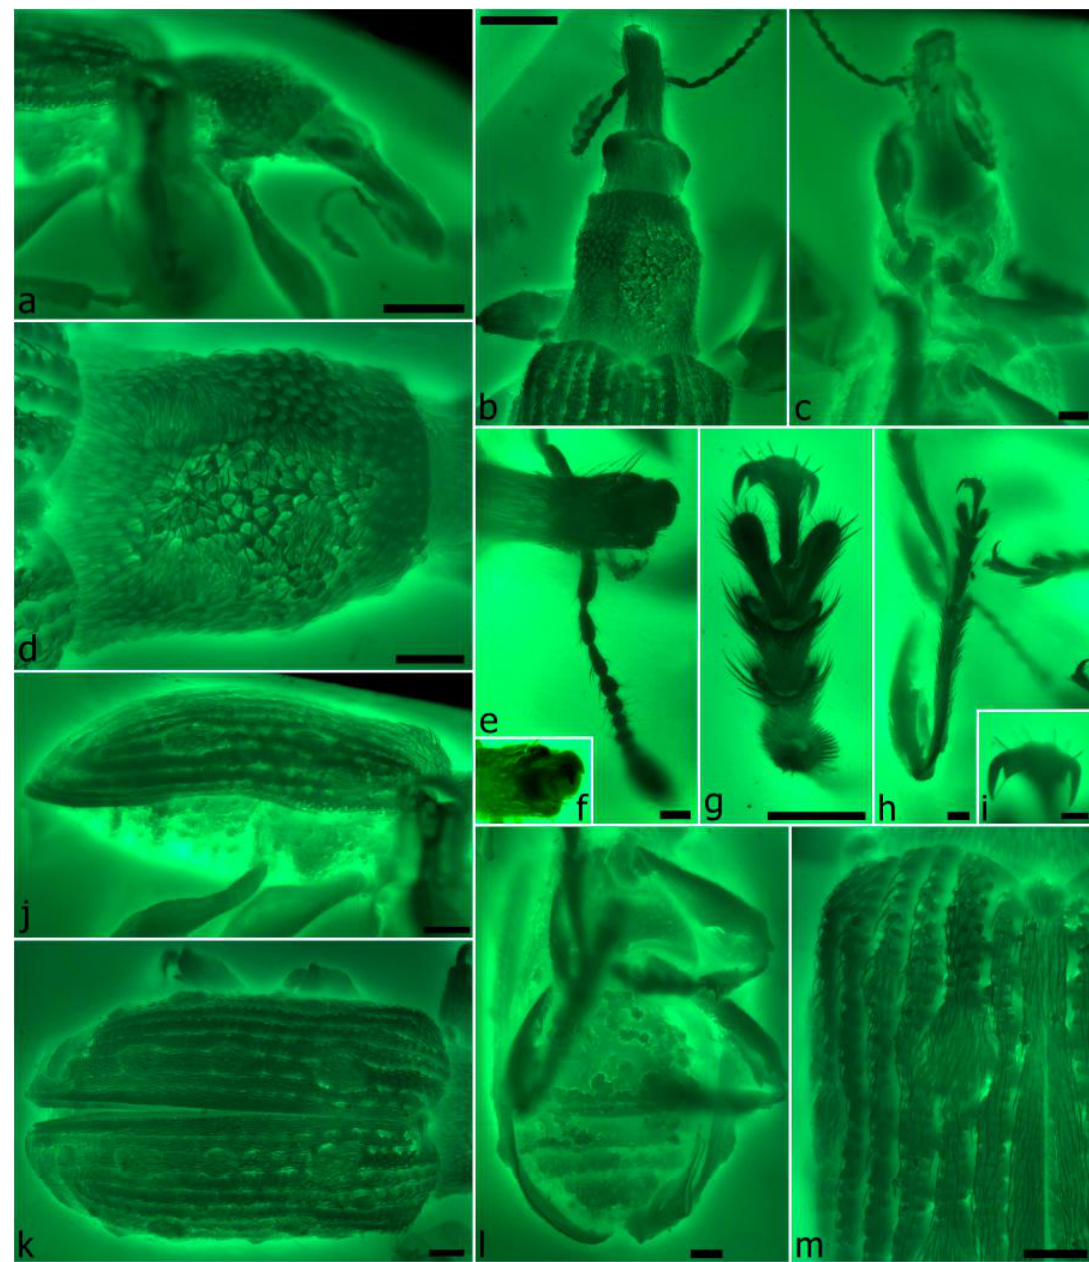
Figure 20. Nugatorhinus chenyangi sp. n., holotype. Images taken under fluorescent green light. Head and prothorax, right lateral ( a ); same, dorsal ( b ); same, ventral ( c ); pronotum, dorsal ( d ); rostrum and antenna, dorsal ( e ); apex of rostrum and mandibles, dorsal ( f ); tarsus, dorsal ( g ); right metatibia and tarsus, dorsal ( h ); tarsal claw, apical ( i ); elytra, right lateral ( j ); elytra, dorsal ( k ); ventrites ( l ); detail of left elytron ( m ). Scale bars: 0.5 mm (a,b); 0.2 mm (c,d,j–m); 0.1 mm (e,g,h); 0.05 mm (i).